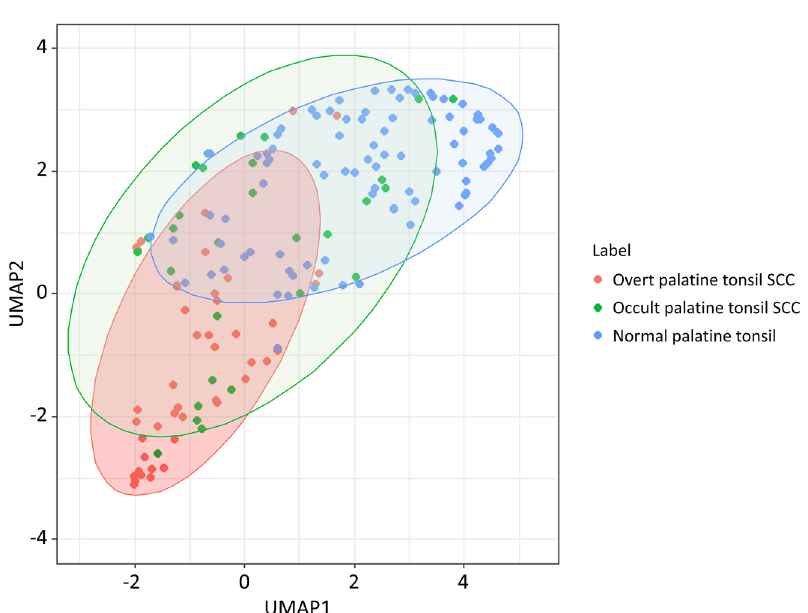
Figure 2. Box and whisker plots of the distribution of the representative values of radiomics features in patients with overt palatine tonsil SCC, occult palatine tonsil SCC, and normal palatine tonsils on T2-weighted images.